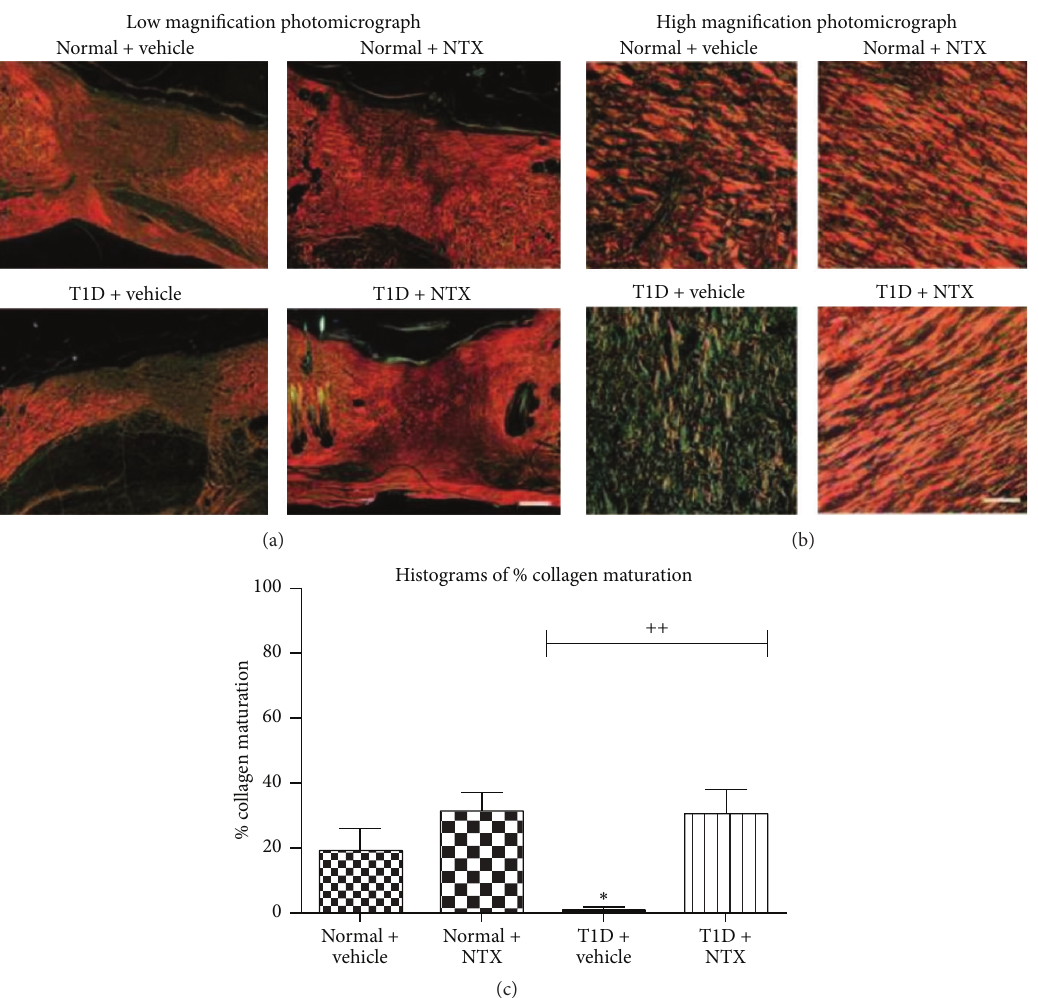
Figure 20: Sirius red-stained healing skin. Diminished collagen formation and maturation in diabetes are restored to normal by NTX treatment. These figures demonstrate remodeling of full-thickness wounds created in T1D and normal rats as measured by collagen formation in the reticular dermis 20 days after wounding and treatment with NTX dissolved in moisturizing cream or cream alone (vehicle). Wounds from normal and T1D rats were treated three times daily with either 10 −5 M NTX or sterile saline (vehicle) dissolved in moisturizing cream. (a) Low magnification (4x) photomicrographs of Sirius red birefringence of skin sections encompassing the full-thickness wound and peripheral unwounded skin; bar = 100mm. (b) High magnification of collagen maturation in Sirius red-stained sections described in (a); bar = 25 mm. (c) Histograms of the percent collagen maturation analyzed by ImageJ at 20 days. Values represent means ± SEM. ∗ Significantly different from normal + vehicle values at 𝑃 < 0.05 ; ++ significantly different between T1D + vehicle and T1D + NTX at 𝑃 < 0.01 (derived from